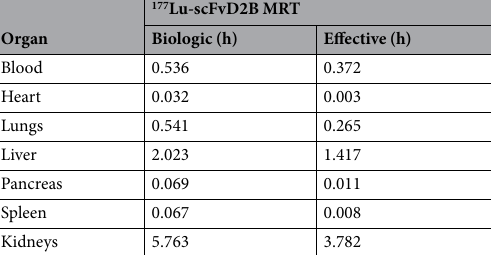
Table 1. Calculated 177 Lu-scFvD2B biological and effective Mean Residence Times (MRT) in the main organs.